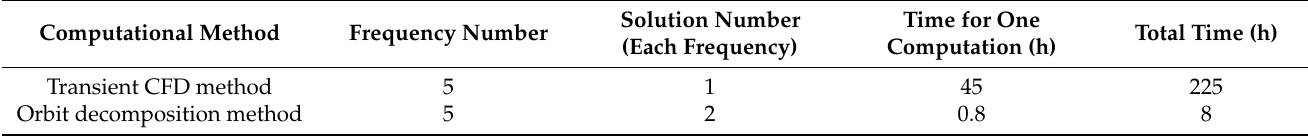
Table 5. Comparison of computational time for two methods.